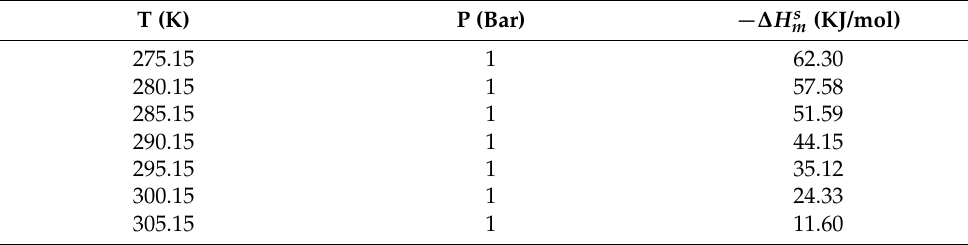
Table 8. Molar heat of solution of H 2 in water.